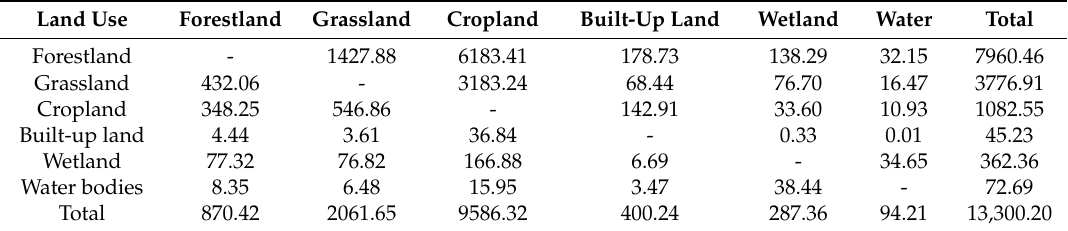
Table 5. Land cover/use conversions (Km 2 ) in Rwanda (1990–2016).